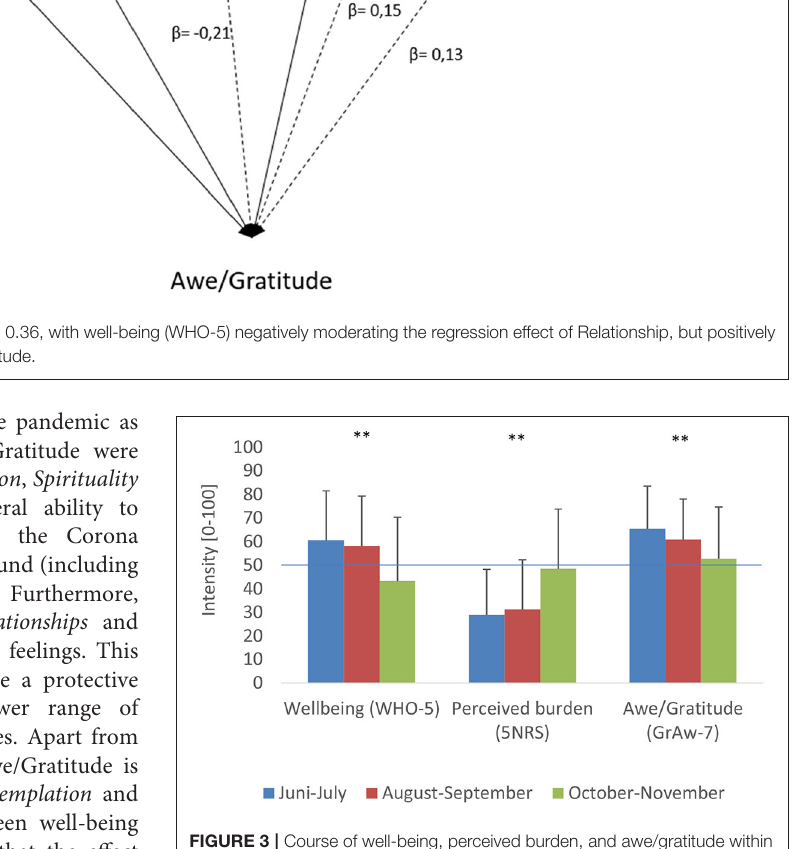
FIGURE 3 | Course of well-being, perceived burden, and awe/gratitude within the 6-month observation period (** p < 0.0001; Spearman